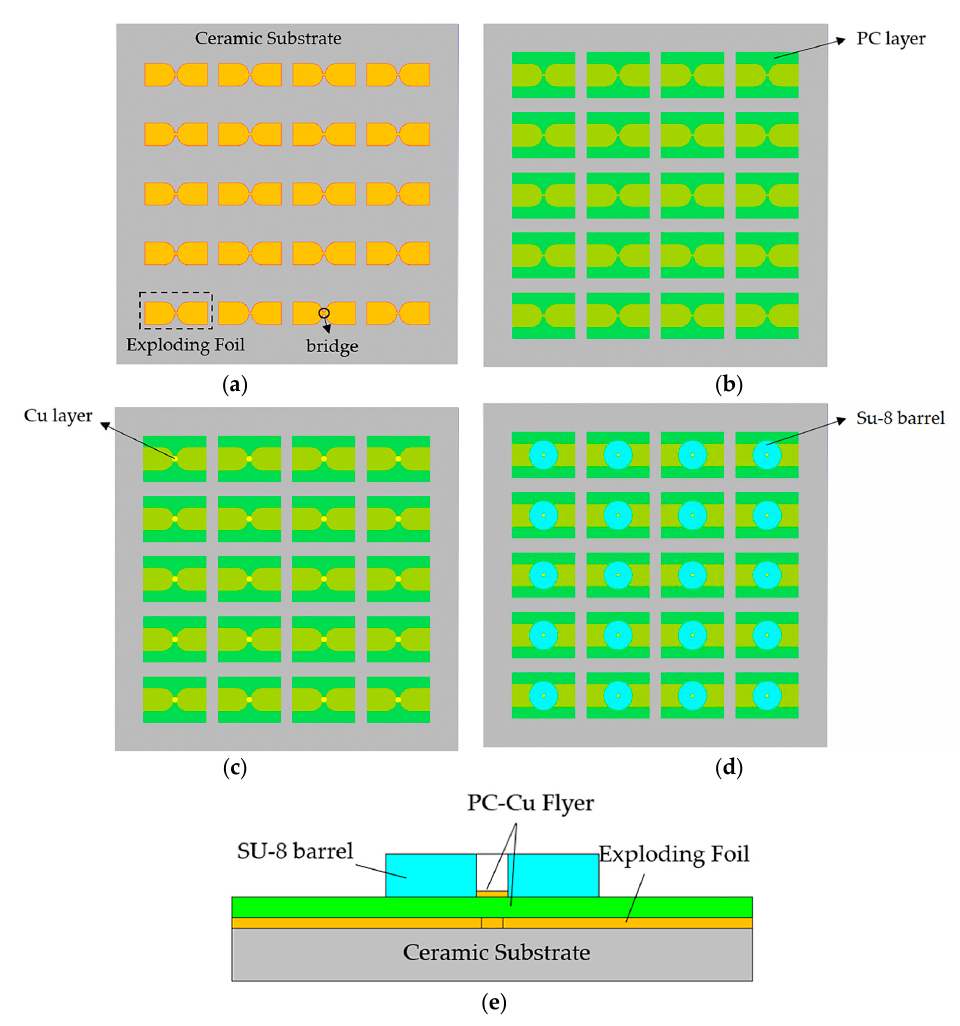
Figure 1. Diagram schematic of the McEFI preparation process: ( a ) exploding foil formed after removing excess copper; ( b ) PC layer deposited on the exploding foil; ( c ) Cu layer deposited on the PC; ( d ) Su-8 barrel formed by ultraviolet lithography; ( e ) cross-section schematic of a single McEFI.